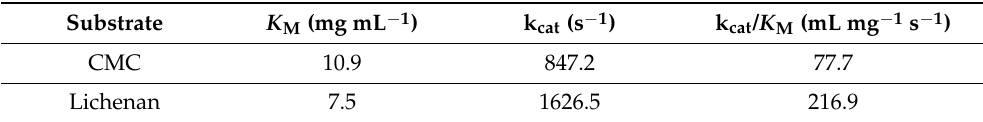
Table 2. Kinetic parameters of AmCel9 on two substrates. Activity was measured under optimal conditions (pH 6 and temperature of 50 ◦ C) for 1